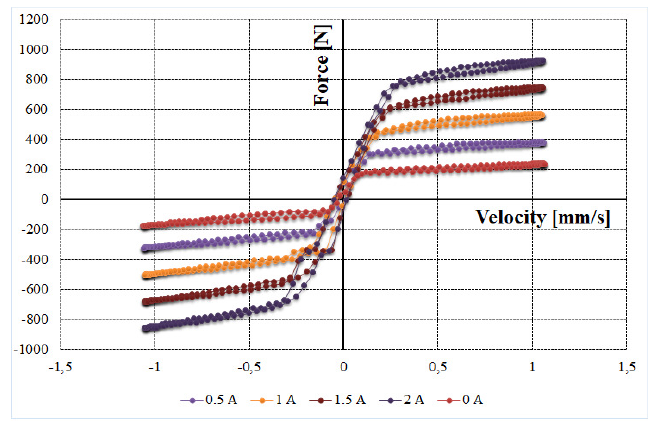
Figure 2. A typical measured characteristic of a MR Damper Force-Velocity